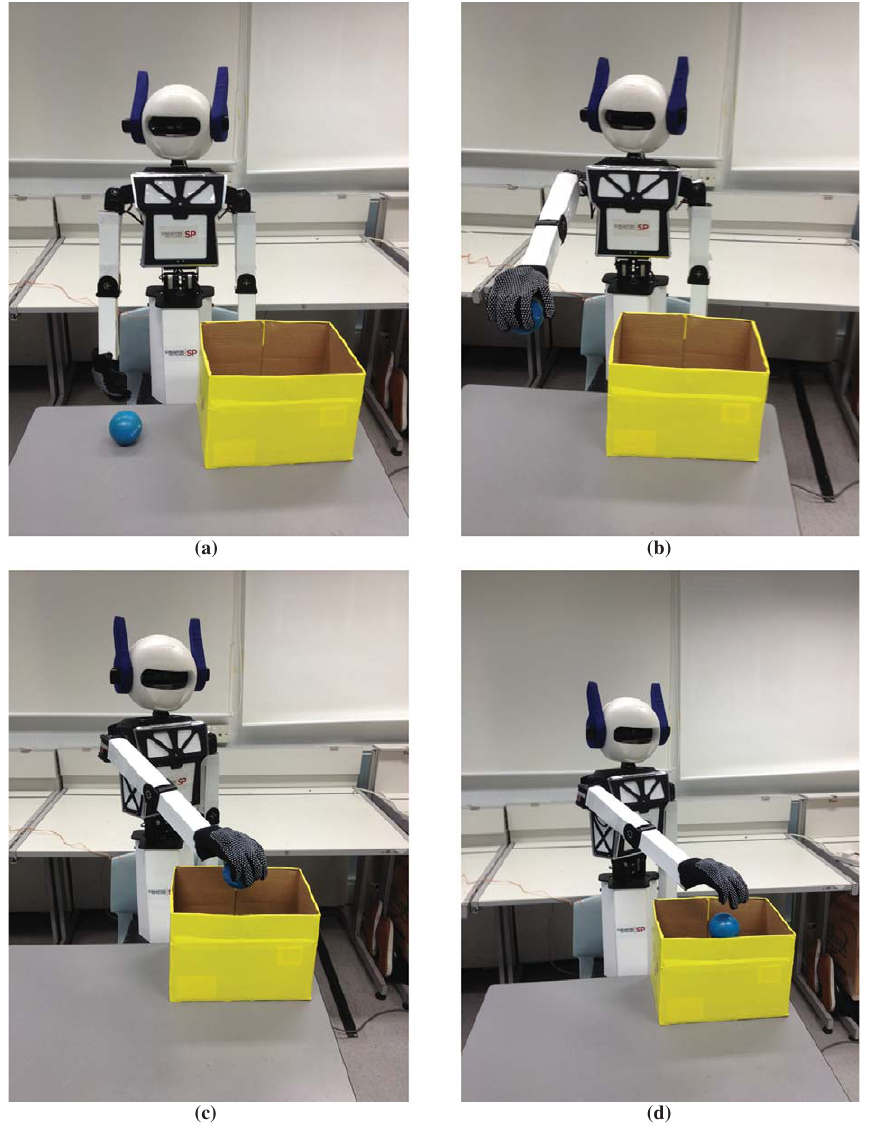
Fig. 6. The robot performance of the Pick and Drop task. See Fig. 4 to compare this with the demonstrators performance.